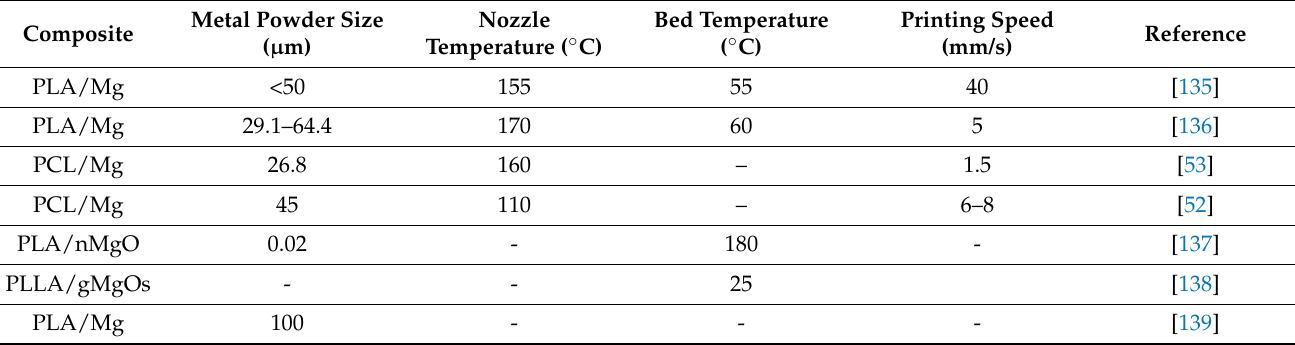
Table 1. Polymer/Mg composite prepared by FDM 3D